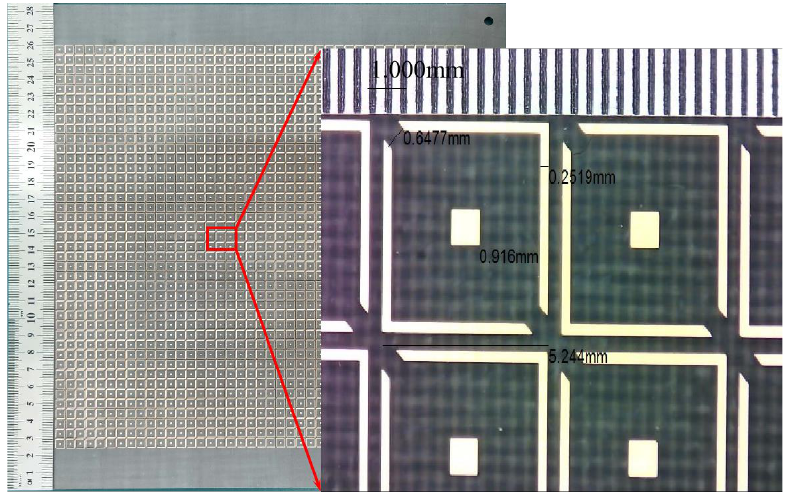
Figure 10. Photograph of the fabricated sample.